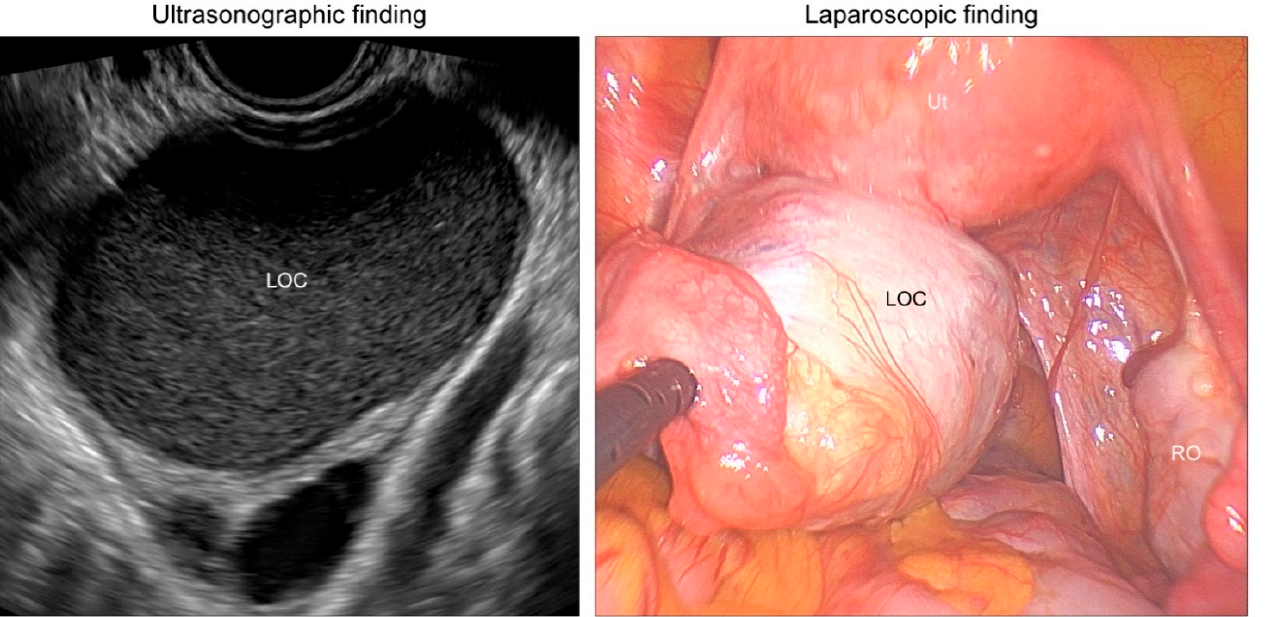
Figure 1. Imaging and operative findings. A 23-year-old woman presenting with intermittent low abdominal pain was referred to our institution with the possibility of an ovarian tumor. Preoperative ultrasonography revealed a 6.5 cm hypoechoic cystic mass in the left adnexa (LOC), suggestive of an ovarian endometriotic cyst. She underwent a laparoscopic left ovarian cystectomy. During laparoscopy, an endometrioma-like cystic mass was detected. The LOC contained chocolate-like fluid. The right ovary (RO) and uterus (Ut) were unremarkable except for a focal filmy adhesion between the anterior uterine serosa and peritoneum. No cul-de-sac obliteration was identified.